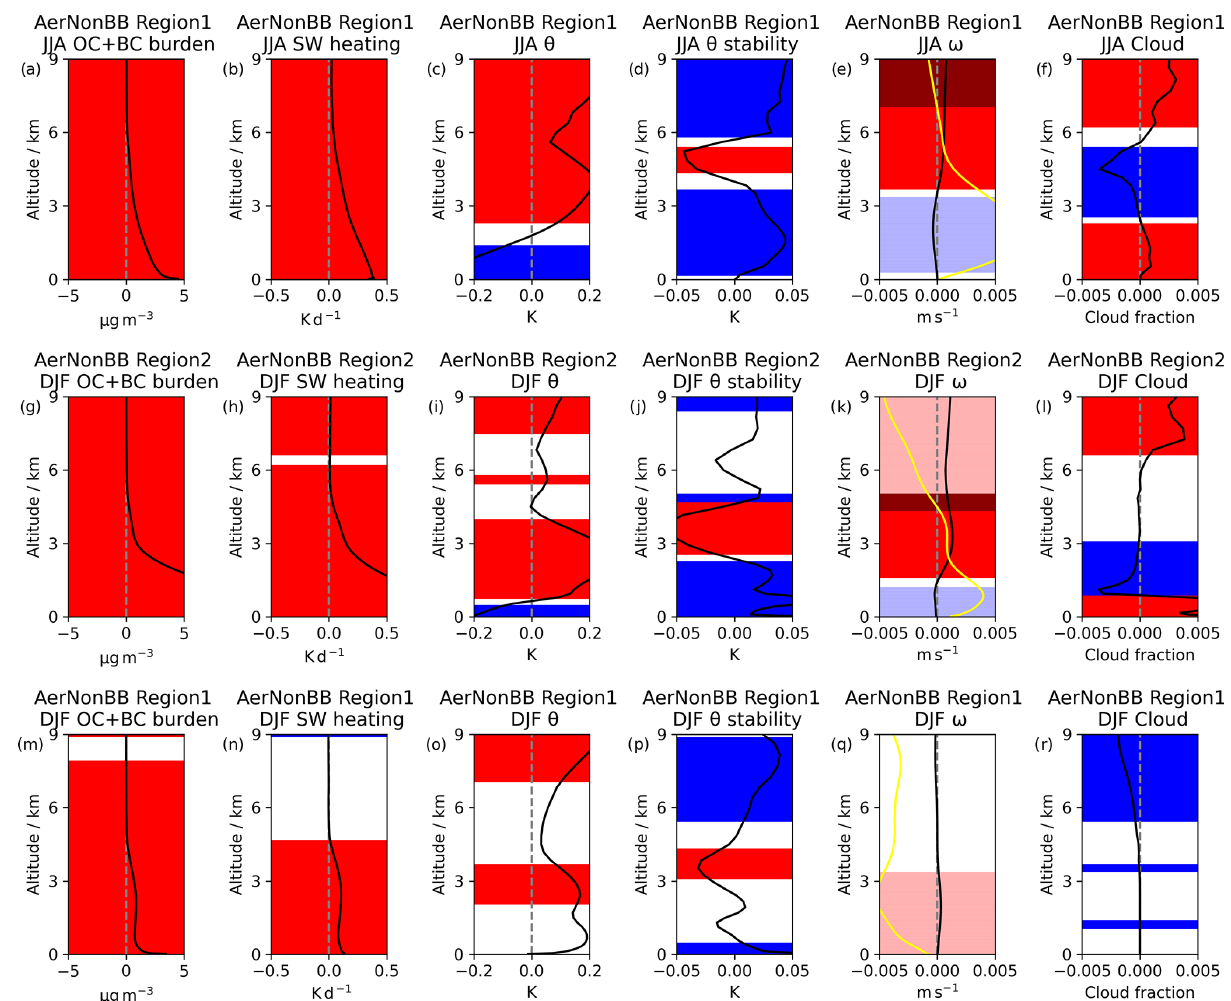
Figure 8. Changes in the vertical profile of carbonaceous aerosol burden (a, g, m) , clear-sky SW heating (b, h, n) , potential temperature ( θ , c, i, o ), potential temperature vertical gradient calculated at each level as the potential temperature at the height immediately above the level minus at that level (d, j, p) , air vertical velocity ( ω , e, k, q ), and cloud (f, l, r) over Region 2 in JJA (a–f) and Region 1 and Region 2 in DJF (g–l, m–r) in 2070–2100 under the AerNonBB experiment relative to the control. The control vertical velocity profile is indicated in yellow. Coloured horizontal lines indicate significant increases (red) or decreases (blue). The vertical velocity colour shades are modified depending on the sign of the change relative to the control baseline: lighter red and blue when the change is enhancing the background, normal when opposite in direction to the background but with the change weaker in magnitude, and darker when opposed with higher magnitude than the control, acting to reverse the